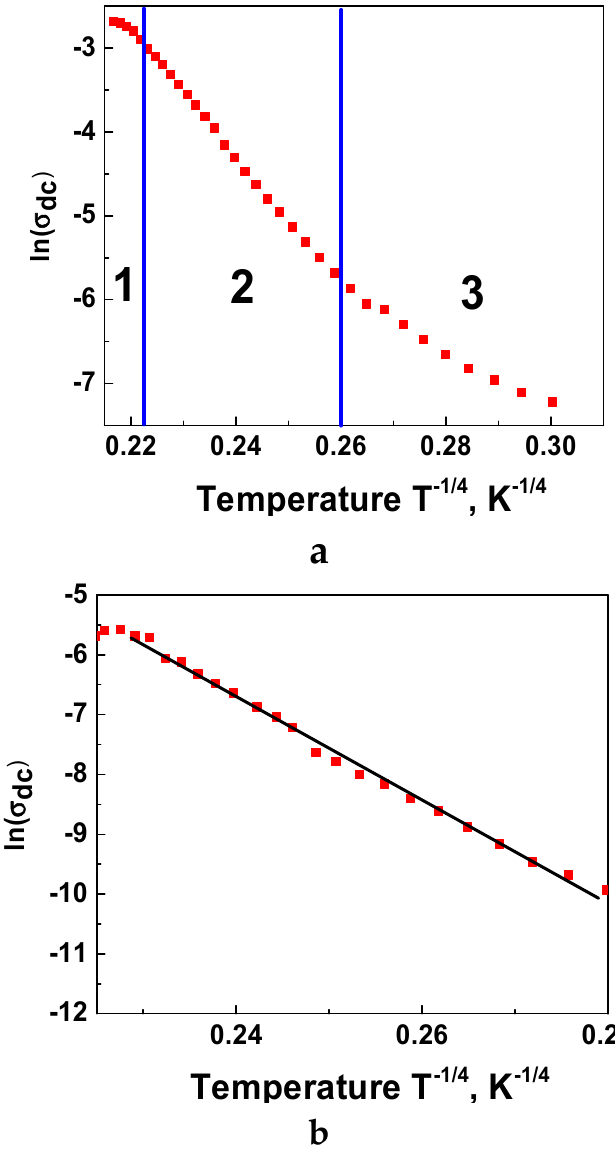
Figure 7. Dependence of ln( σ DC ) on T –1/4 for La-CMFCNO ( a ) and Nd-CMFCNO ( b ).